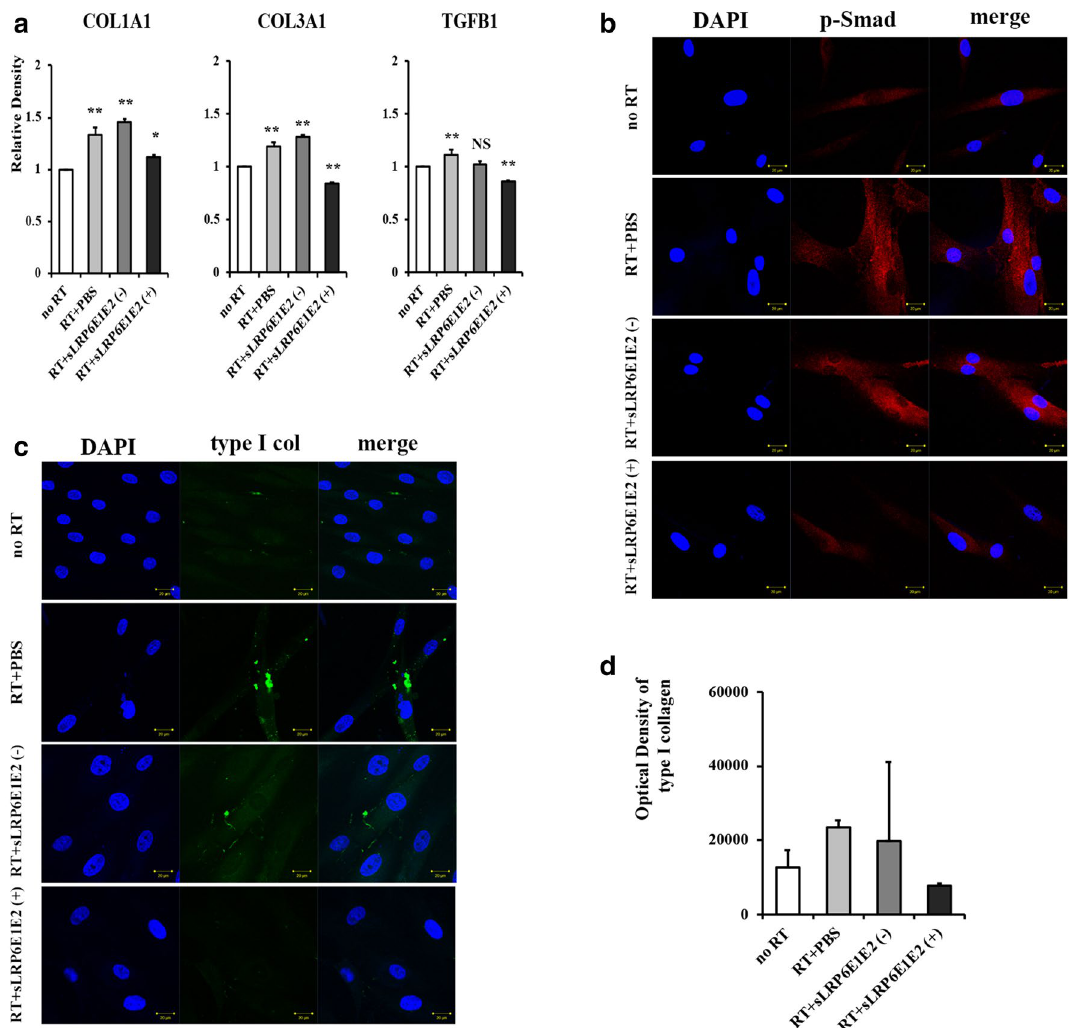
collagen and TGF-β in HDFs were assessed by qRT-PCR after transduction with dE1-k35/sLRP6E1E2 or dE1-k35. * p < 0.05; ** p < 0.01 vs no radiation. Irradiated HDFs were transduced with dE1-k35/sLRP6E1E2 or dE1-k35, and immunocytochemical staining for ( b ) phospho-Smad 2/3 (red) and ( c ) type I collagen (green) was performed. DAPI: blue. ( d ) The expression levels of type I collagen were assessed semi-quantitatively using MetaMorph imaging analysis